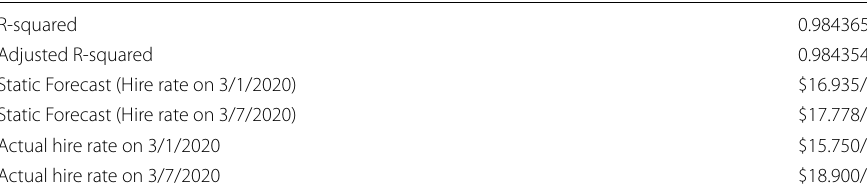
Table 5 Continent–Far East 72.000 dwt. Source : Elaboration by the authors